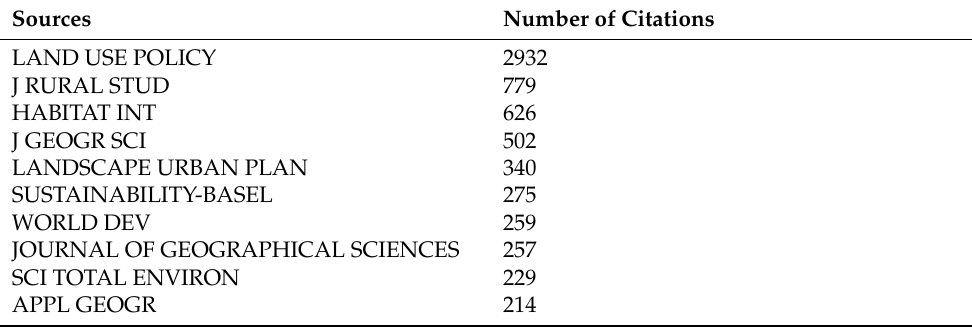
Table 4. The 20 most cited journals in land consolidation and rural